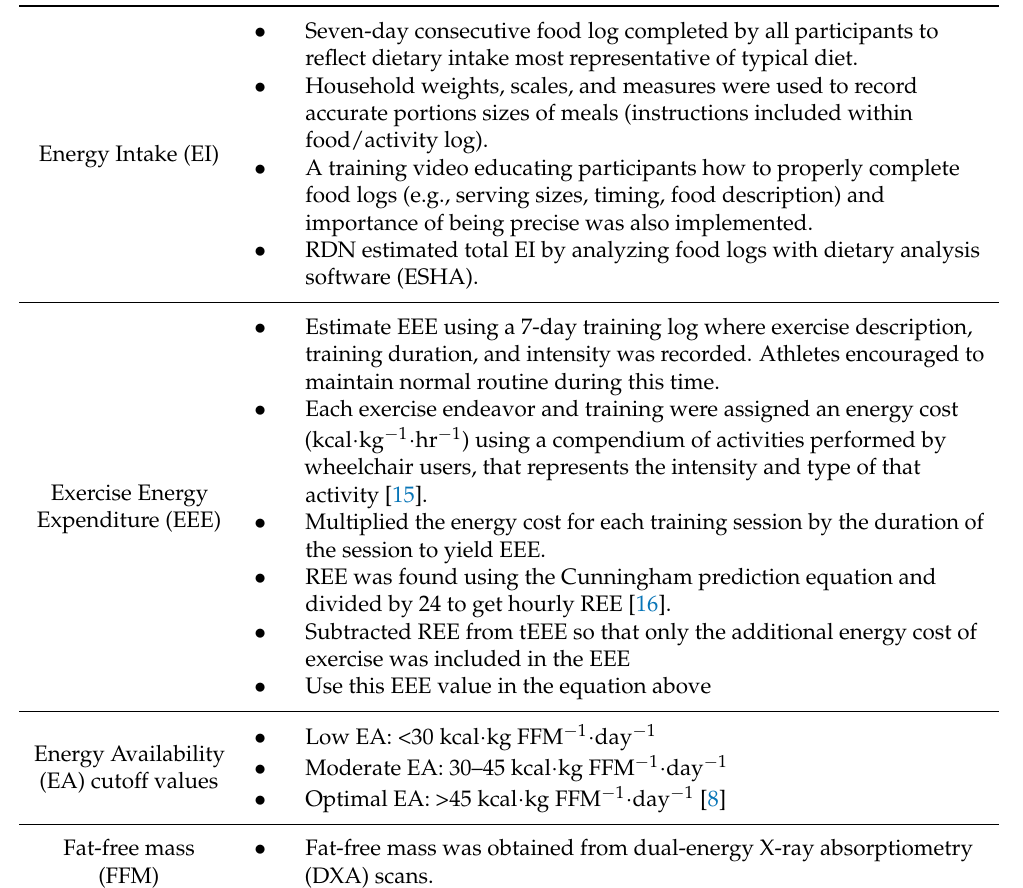
Table 1. Method for assessing energy availability (EA) based on food/activity logs as follows EA = (energy intake (EI)—energy expended from exercise (EEE))/fat free mass